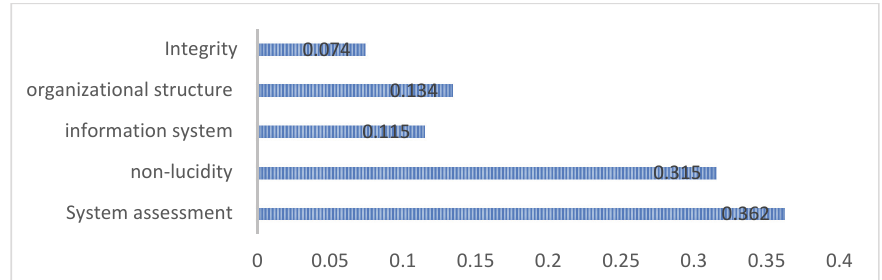
Fig. 2. The results of the implementation of AHP method for ranking barriers